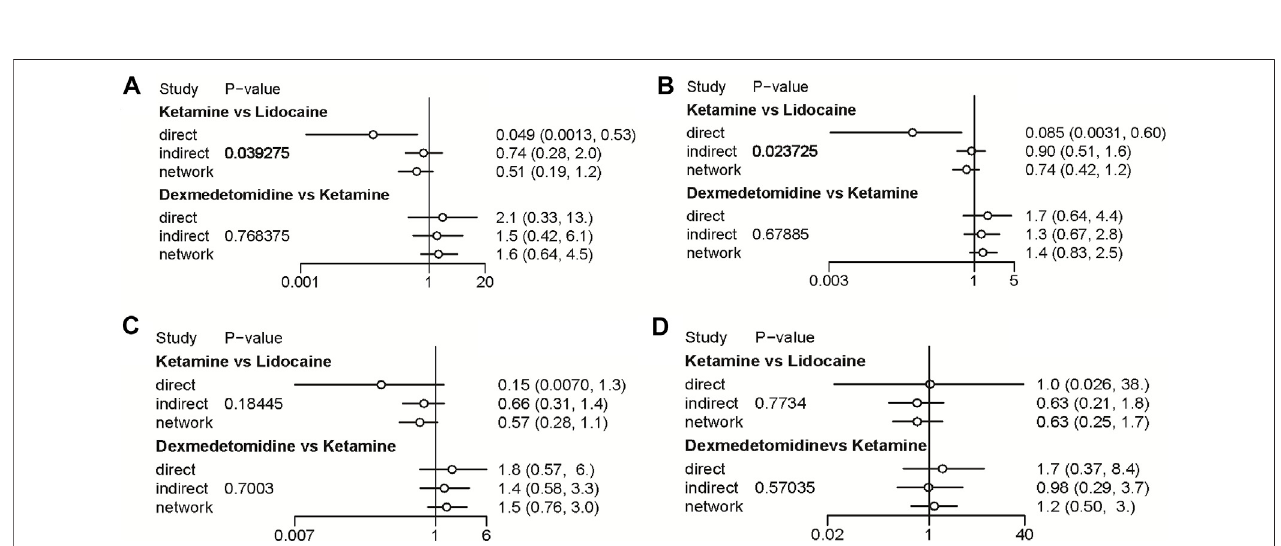
FIGURE 8 | Node-splitting method in comparisons between direct and indirect evidence. (A) Incidence of OIC; (B) Mild severity of OIC; (C) Moderate severity of OIC; and (D) Severe severity of OIC.